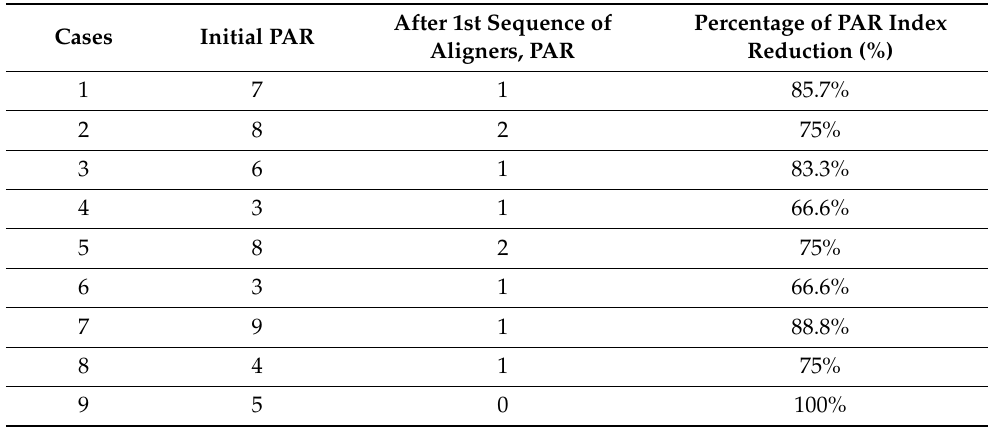
Table 1. Pretreatment peer assessment rating (PAR) index after the first sequence of aligners, the PAR index for each case, and the percentage of the PAR index